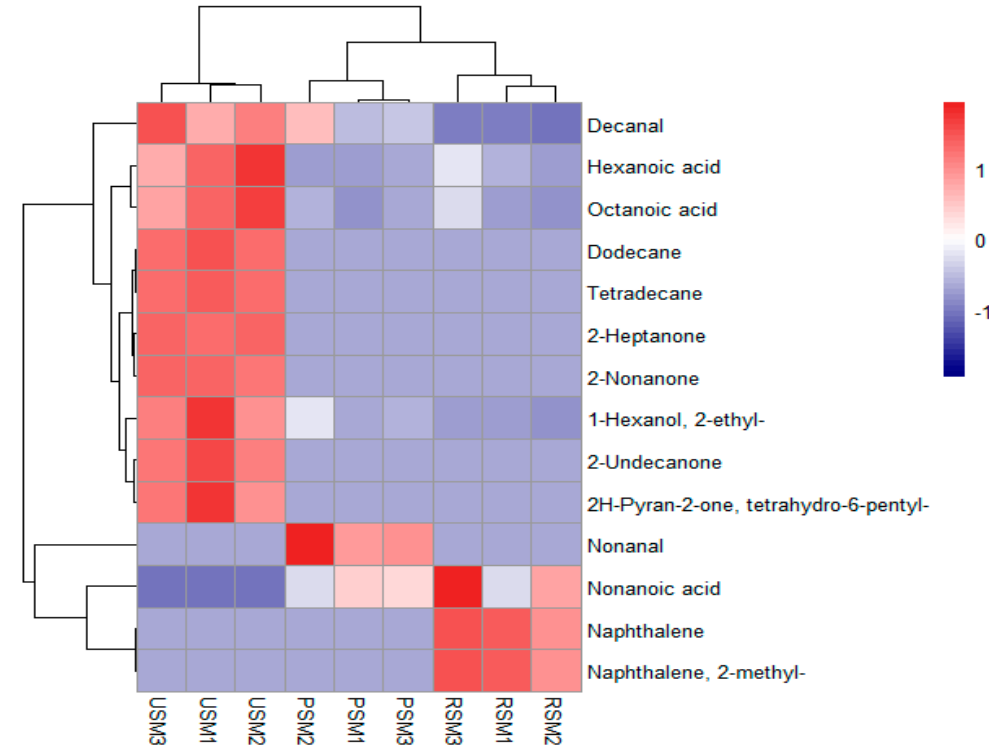
Figure 4. Heat map explains the different concentrations of the volatiles in the three kinds of skim milk samples. (Red represents a high concentration of compounds; white represents a medium concentration of compounds; blue represents a low concentration of compounds.)